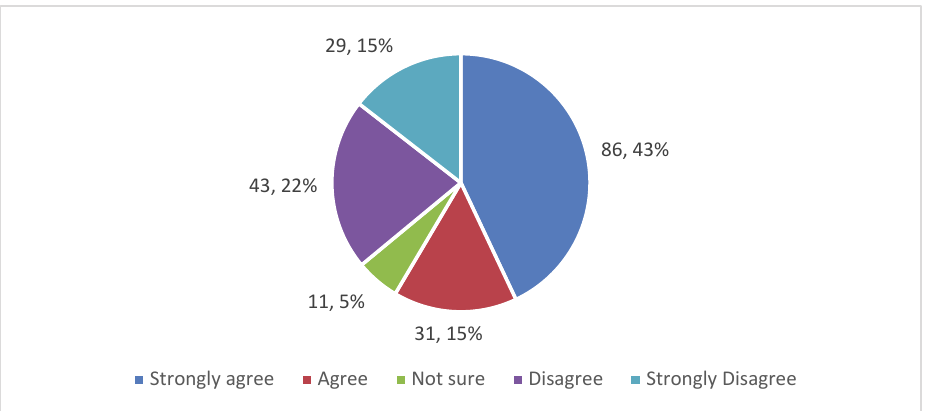
Fig. 3. Opinions on customer focus and organizational performance